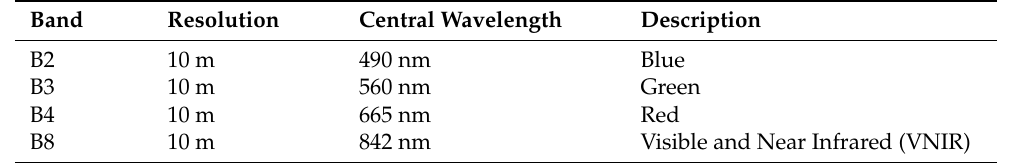
Table 2. Information on Band